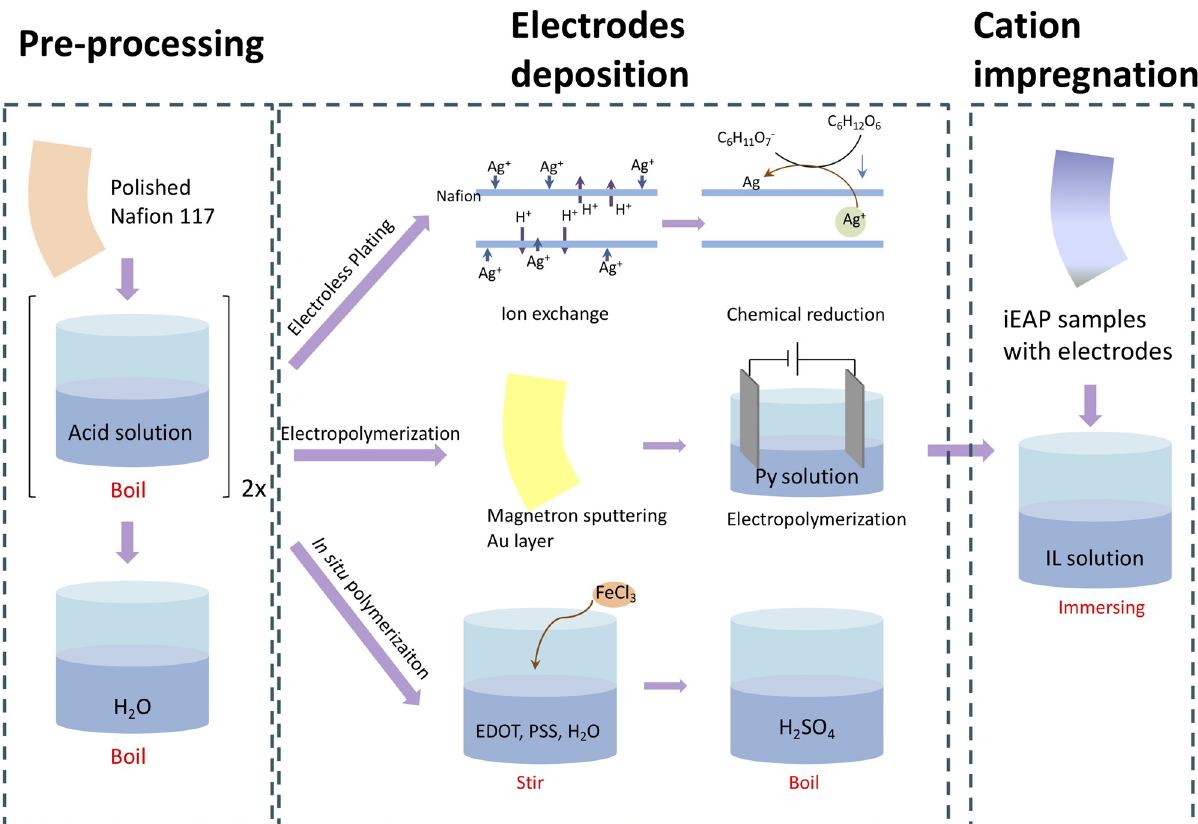
Figure 5: Schematic for the preparation IL - iEAP through chemical